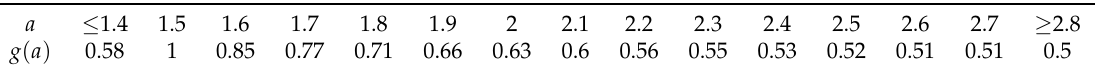
Table 7. Variation of g ( a ) with a